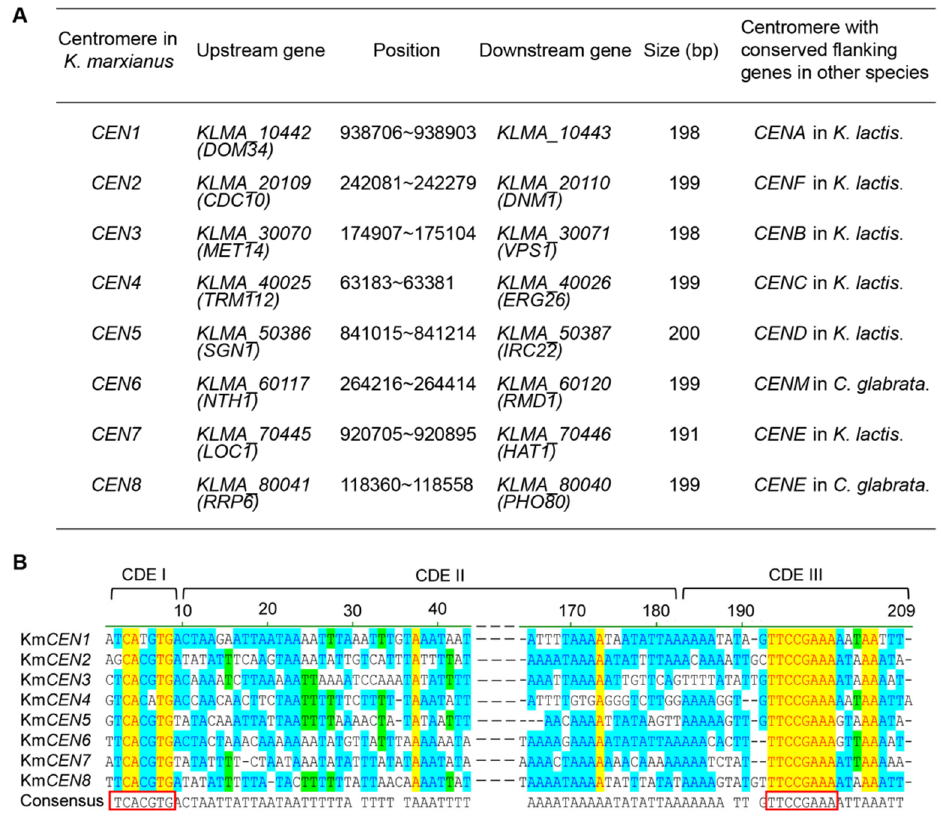
Figure 1. The positions and sequences of centromeres in K. marxianus. ( A ) The positions of centromeres in K. marxianus . The positions of centromeres refer to the positions in the genome of DMKU3-1042 [48]. ( B ) Alignments of centromeres in K. marxianus. The consensus sequences are in the red box. Color setup of the alignments: blue for conservative, green for similar, yellow for identical. The alignments were performed by Vector NTI (Thermo Fisher Scientific).